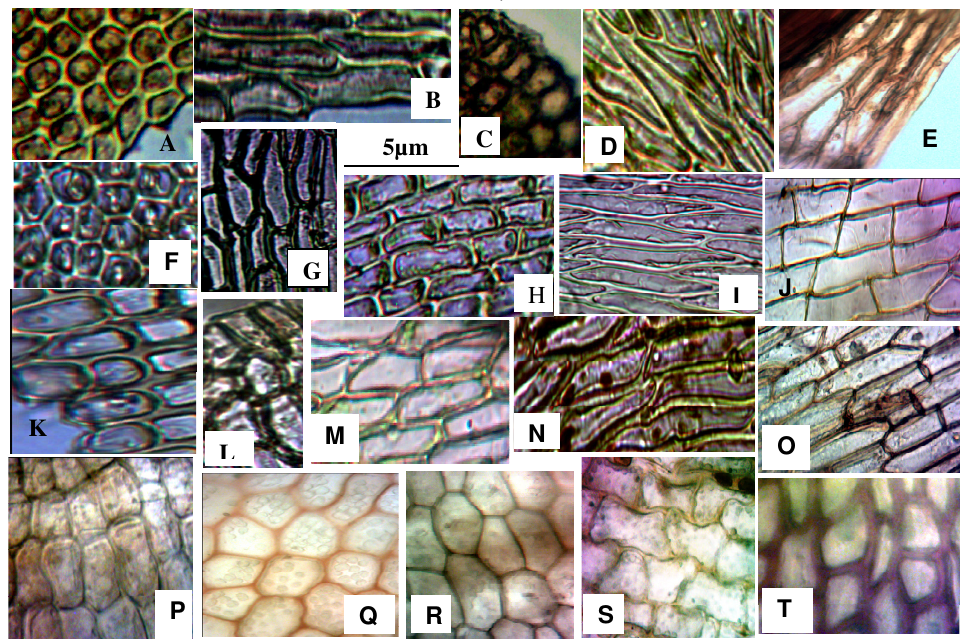
Fig. 3. Anatomical features of the Lamina cells and Exothecial cells of the moss species studied. A: Upper region of Hyophila crenulata leaf; B: Upper region of Thuidium gratum leaf; C: Upper region of Barbula lambarenensis leaf; D: Upper region of Stereophyllum nitense leaf; E: Upper region of Bryum coronatum leaf; F: Mid-region of Hyophila crenulata leaf; G: Mid-region of Thuidium gratum leaf; H: Mid-region of Barbula lambarenensis leaf; I: Mid-region of Stereophyllum nitense leaf; J: Mid-region of Bryum coronatum leaf; K: Basal region of Hyophila crenulata leaf; L: Basal region of Thuidium gratum leaf; M: Basal region of Barbula lambarenensis leaf; N: Basal region of Stereophyllum nitense leaf; O: Basal region of Bryum coronatum capsule; P: Exothecial cells of Hyophila crenulata capsule; Q: Exothecial cells of Thuidium gratum capsule; R: Exothecial cells of Barbula lambarenensis capsule; S: Exothecial cells of Stereophyllum nitense capsule; T: Exothecial cells of Bryum coronatum